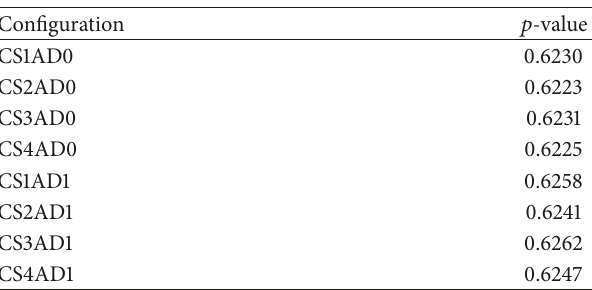
Table 8: Summary of normality test.